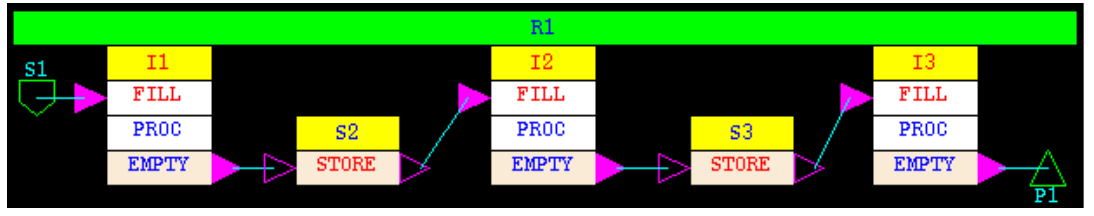
Figure 8. Recipe network for Example 3. Table 3. Key process parameters for Example